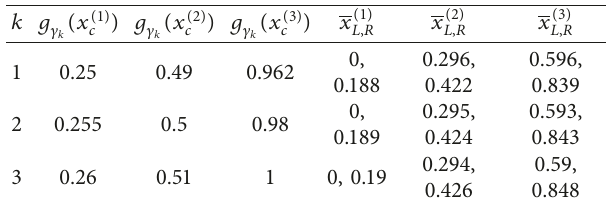
Figure 3: Cobweb diagrams of the maps g 􏽮 􏽯 3 given by equation (32) with x c i i � 1 Table 2: Maximum values and fixed points of the multimodal � 3 . 846, c � 3 . 922, and c � 4. 􏽮 􏽯 3 , for c family g c 1 2 3 k � 1 k